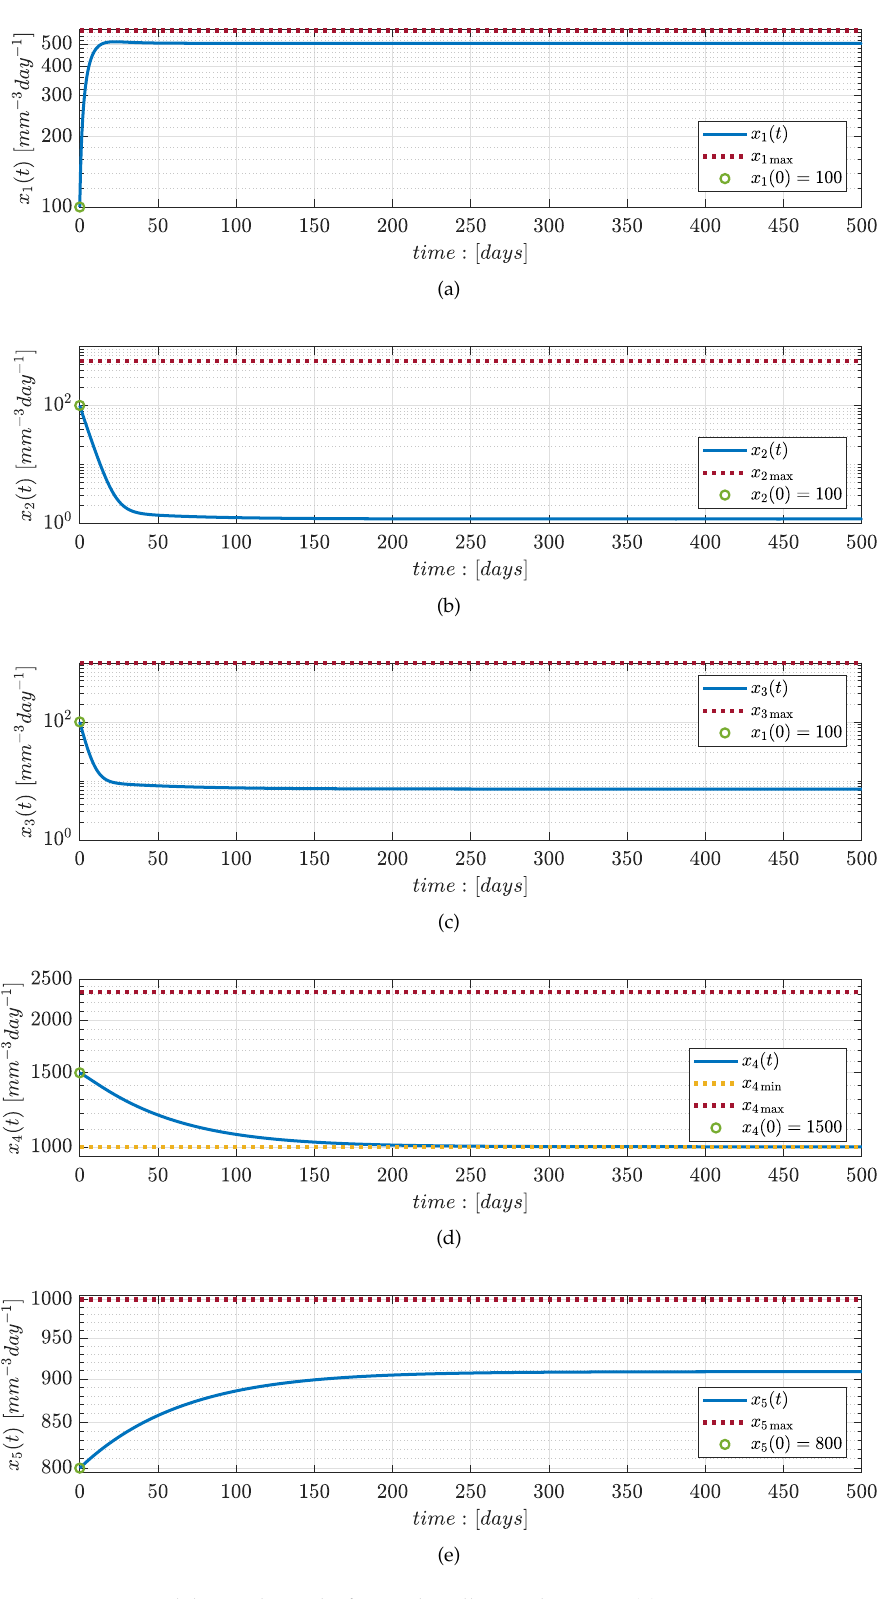
Figure 2. Upper and lower bounds for each cell populations. ( a ) Maximum concentration of resting macrophage cells. ( b ) Maximum concentration of activated macrophage cells. ( c ) Maximum concentration of antigen cells. ( d ) Minimum and maximum concentrations of T-cells. ( e ) Maximum concentration of β